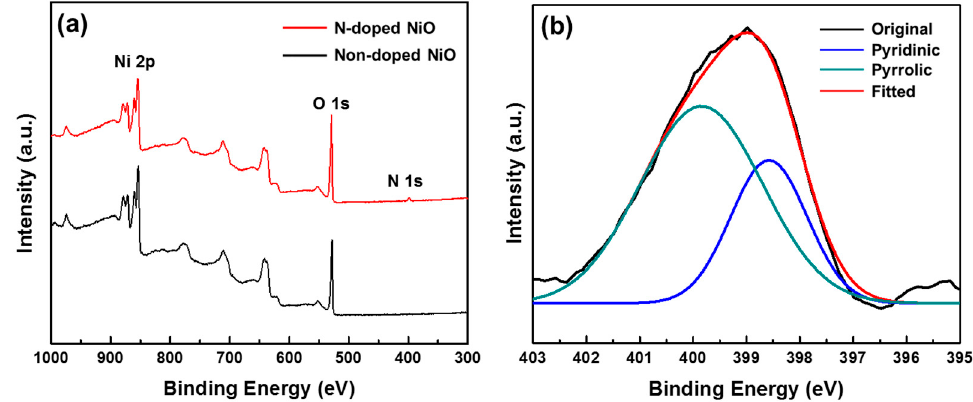
Figure 5. XPS spectra of N-doped and non-doped NiO NSs: ( a ) wide scan spectra and ( b ) N 1s spectra of N-doped NiO with deconvoluted peaks.